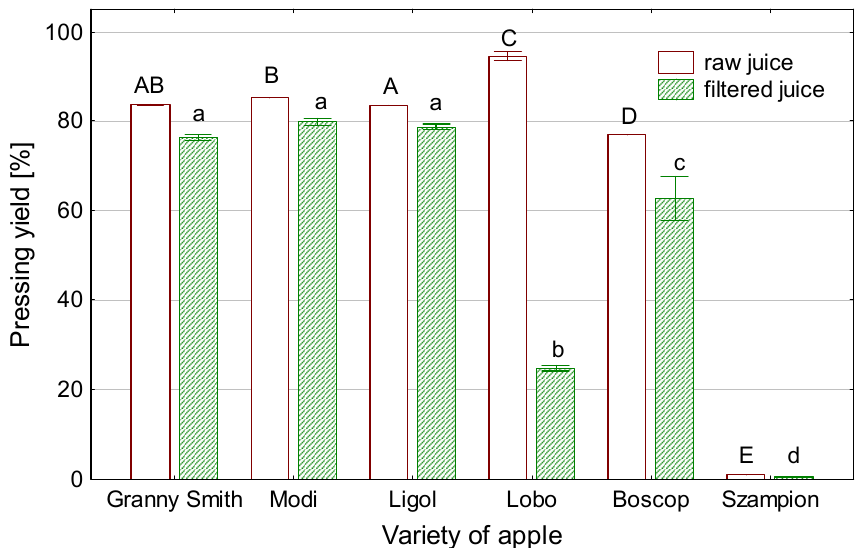
Figure 2. Raw juice and filtered juice pressing yield depending on apple variety. Different capital letters indicate values significantly different at p < 0.05 for raw juices. Different lowercase letters indicate values significantly different at p < 0.05 for filtered juices.